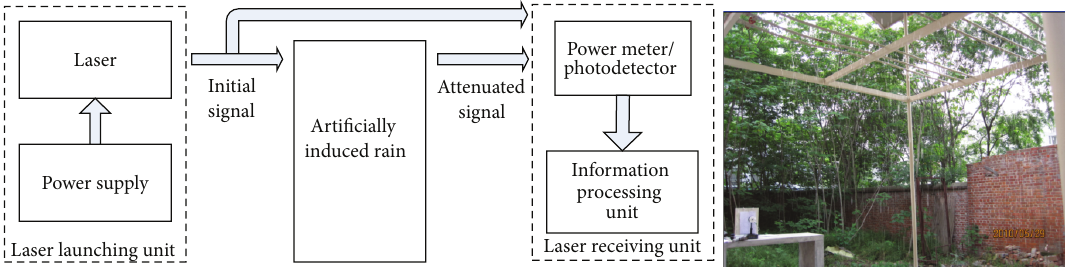
Figure 6: Experimental arrangement for determination of the rain’s attenuation.